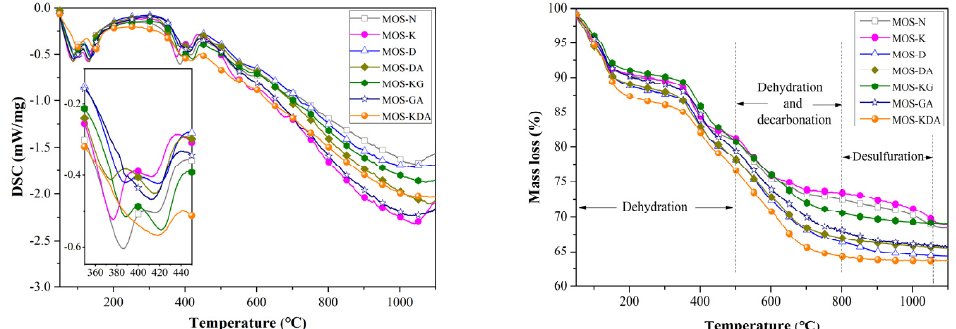
Figure 6. TG-DSC curves for the control and mixed samples with different modifiers.